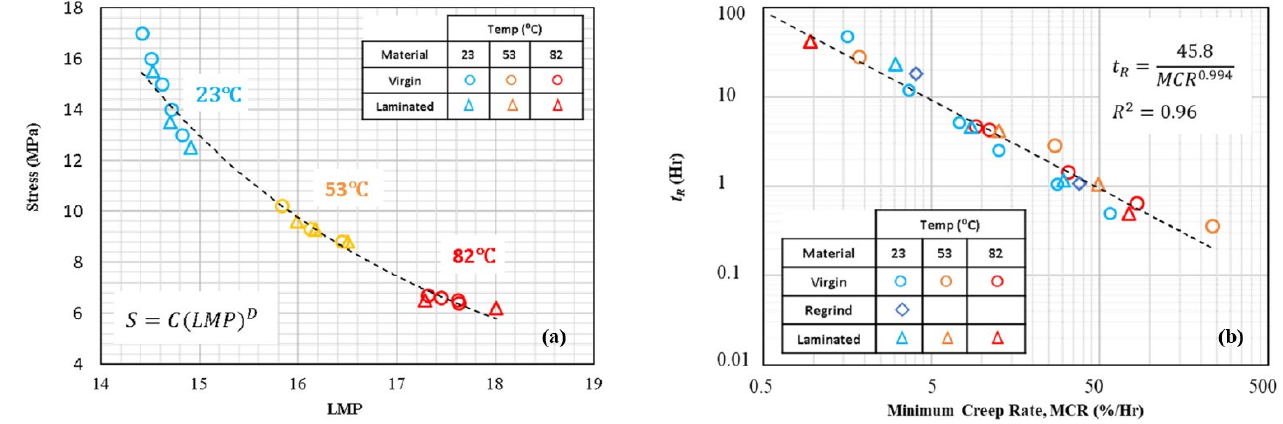
. ε min ( b ) for HDPE under